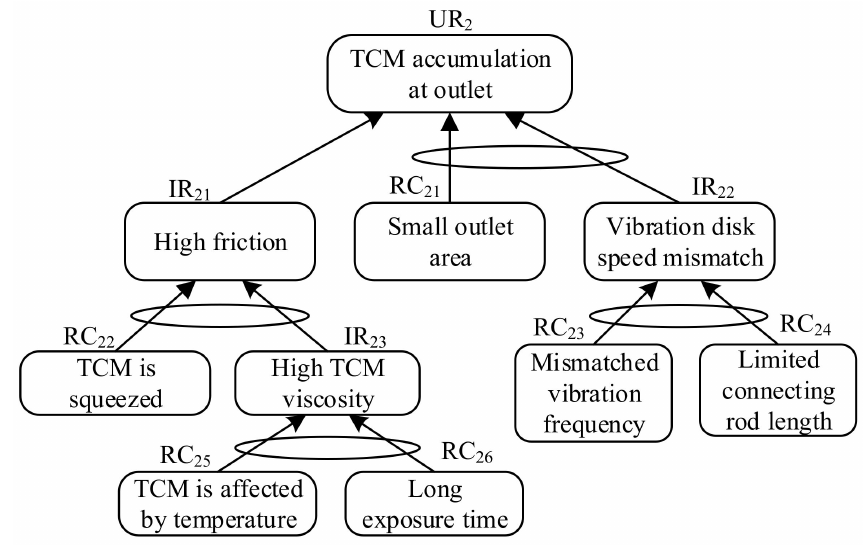
Figure 18. CRT model of “TCM accumulation at outlet”.